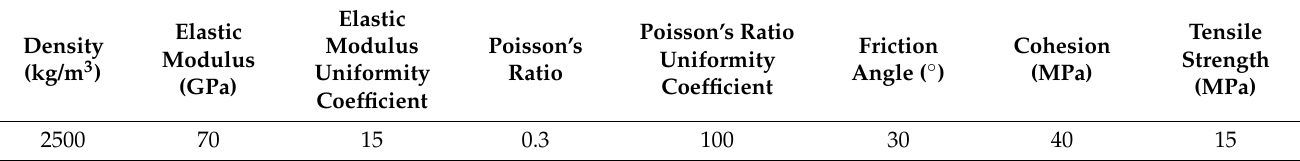
Table 1. Mechanical parameters of the Brazilian disc model.